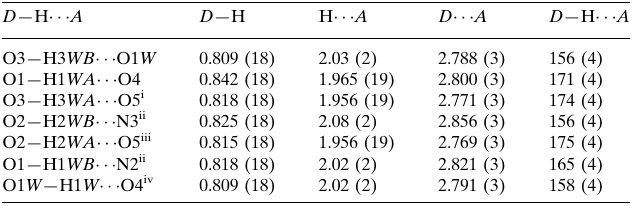
Data collection Rigaku Mercury2 diffractometer Absorption correction: multi-scan ( CrystalClear ; Rigaku, 2005) T min = 0.708, T max = 0.833